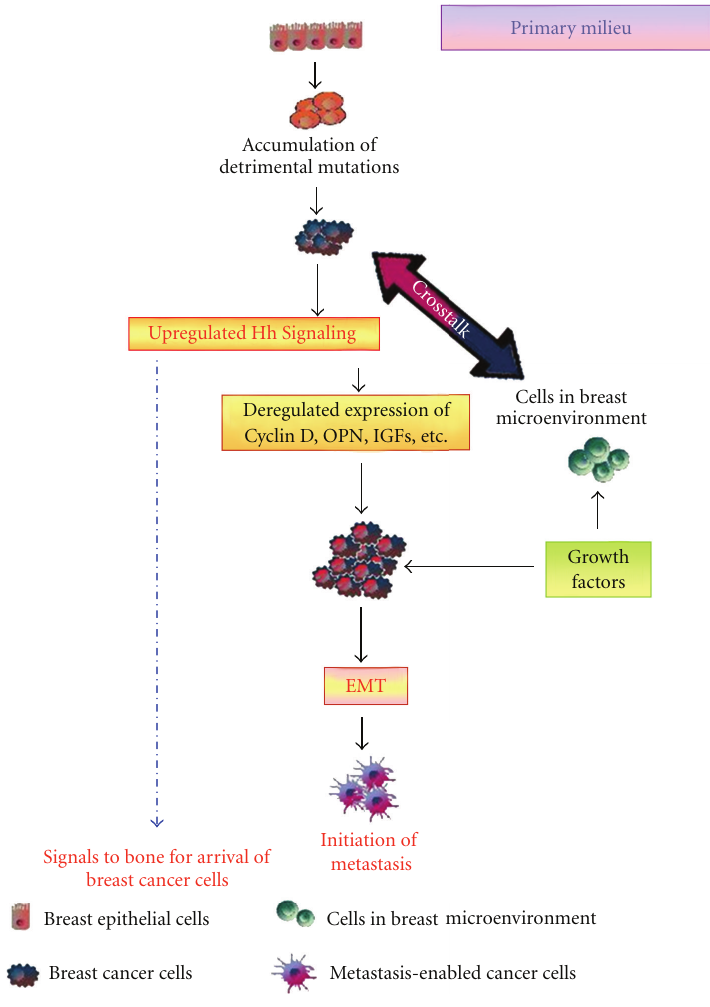
Figure 1: Hh signaling conditions the milieu to support metastasis of breast cancer cells to the bone. Depicted here is the first of the two microenvironments, the milieu of the primary tumor. Hh signaling in the tumor cells impacts the stromal cells in the environment, which in turn amplify paracrine Hh signaling by producing growth factors that propel epithelial-mesenchymal transition. Concomitantly, secreted, soluble proteins produced by the primary tumor contribute towards conditioning the secondary site for the arrival of the tumor